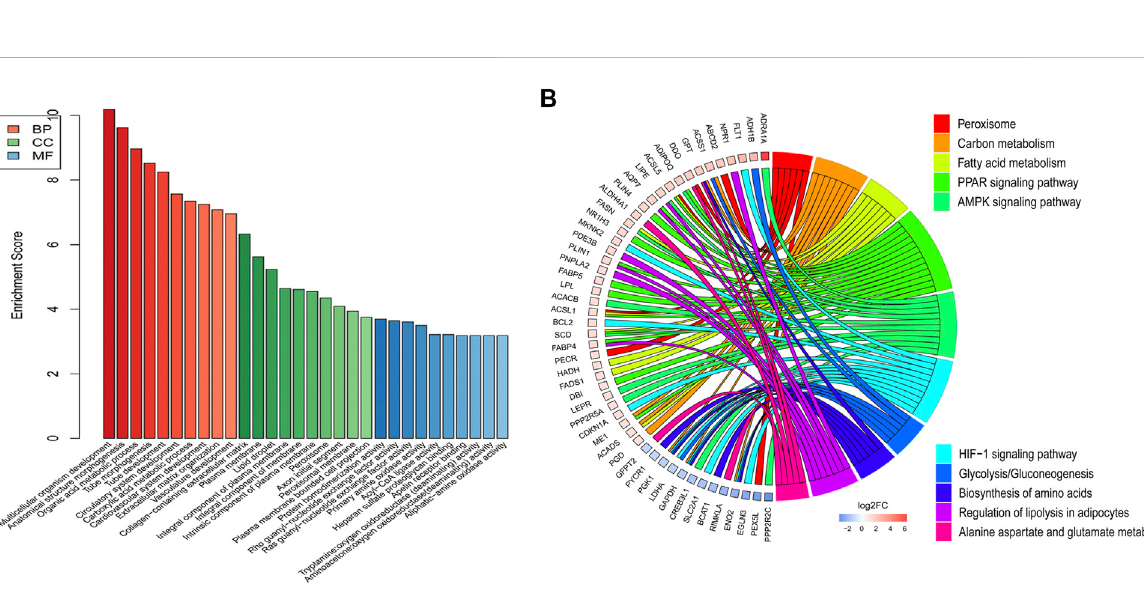
NR_038937.1 were the top 3 lncRNAs that appeared to have various target genes. SPN and OR1AIP2 were target genes of all the top 3 lncRNAs. HAUS2, TRPV1, PTCHD4, SKA1, NQO1,